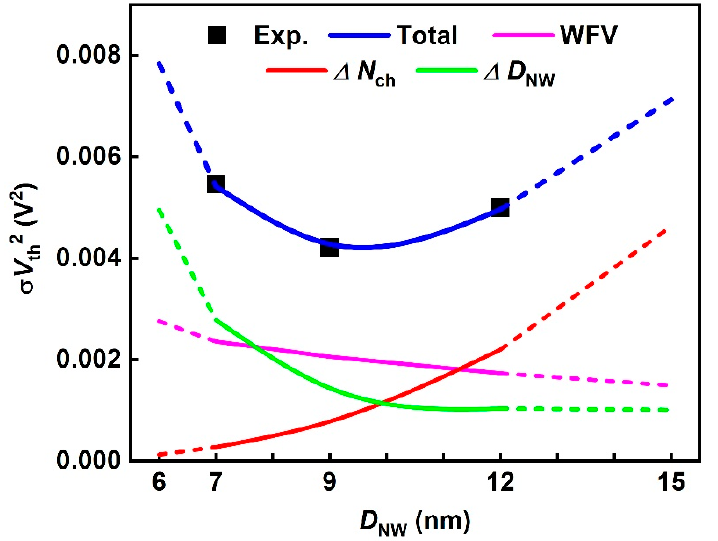
Figure 7. Model fitting results (blue line) considering WFV (pink line), ∆ N ch (red line), and ∆ D NW (green line) for the measured value of squared σ V th (black dots). The model fits were extrapolated for D NW of 6 and 15 nm (dashed line).